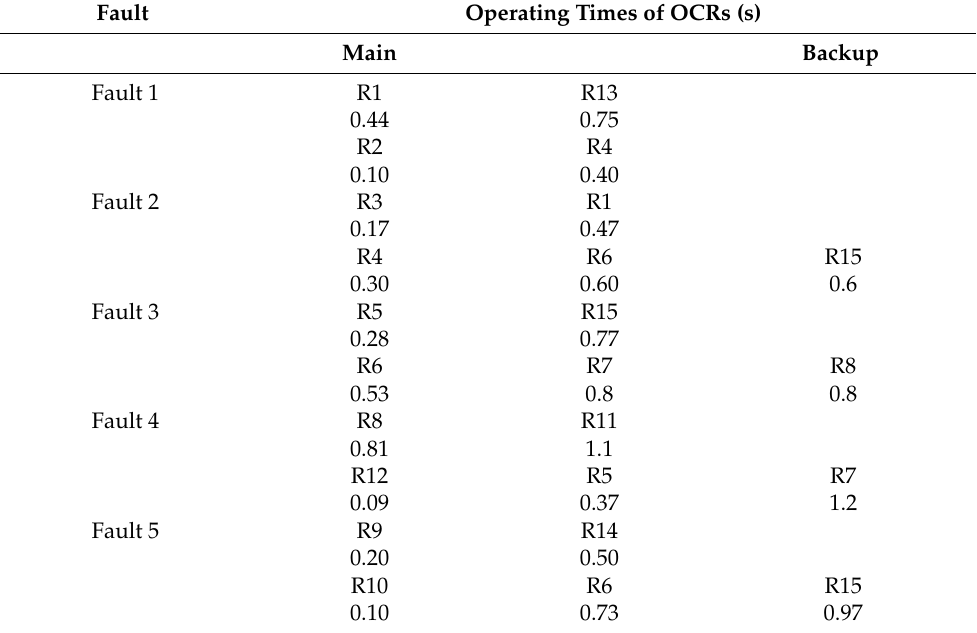
Table 6. Operating times for Scenario